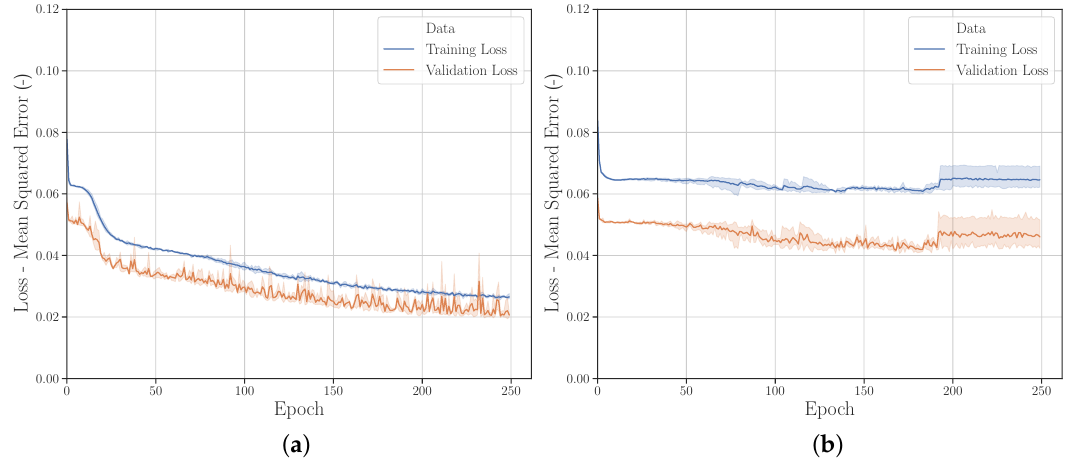
Figure 15. Learning curves with dropout ( a ) 0.00 and ( b )